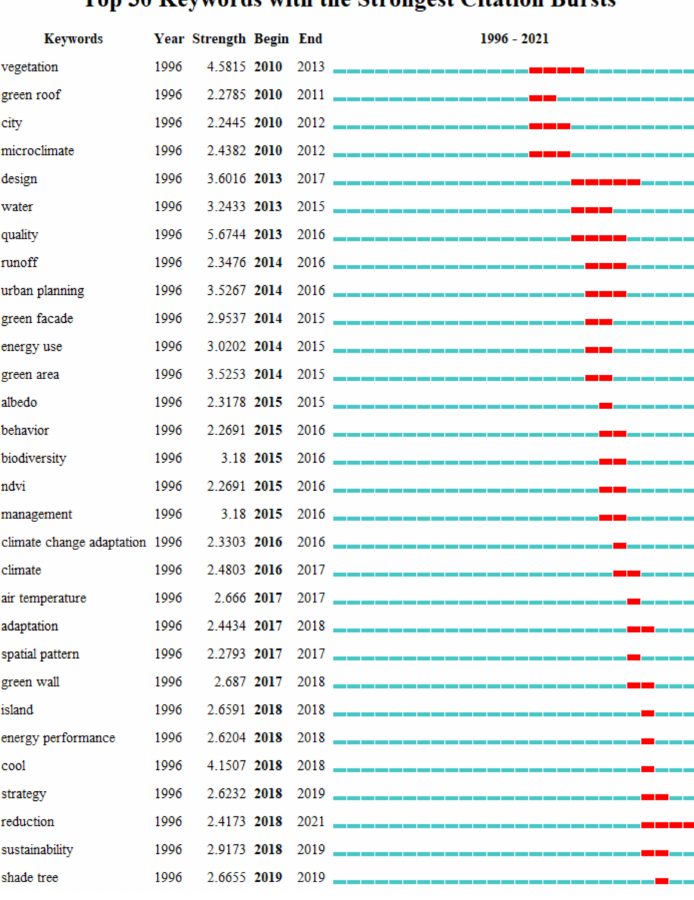
Figure 5. Timeline of